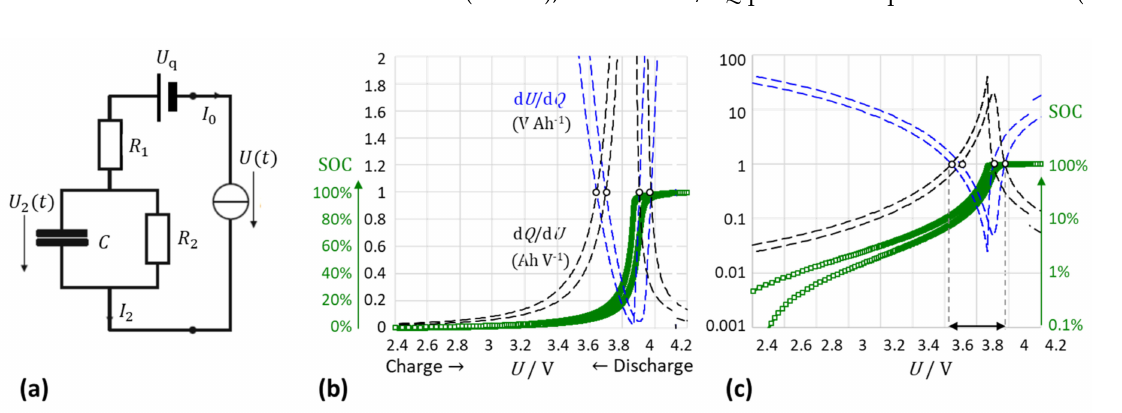
Figure 1. General model of a lithium-ion battery: ( a ) Network elements: U q = 4.2 V, Q 0 = 2 Ah, C = 12500 F, R 1 = 0.004 Ω , R 2 = 0.02 Ω . ( b ) Calculated battery voltage U (green), differential capacity d Q /d U (“IC”, dashed black) and “incremental voltage” d U /d Q (“DV”, V/Ah, dashed blue) versus state-of-charge for constant current charge and discharge ( I = 0.5 A) on a linear scale. ( c ) Calculated values on the logarithmic scale. ( ◦ ) Intersection points: Charge: 3.70 V and 3.98 V; discharge 3.64 V and 3.91